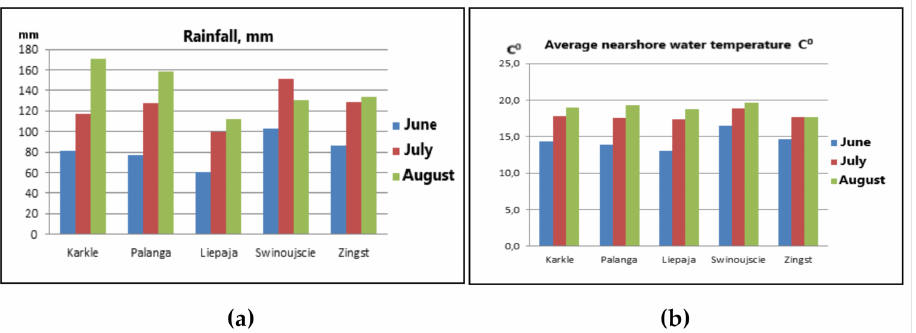
Figure 4. Climate parameters at South Baltic seaside and marine resorts in the summer months from 2010 to 2018 (our compilation): ( a ) Average monthly rainfall (mm); ( b ) Average nearshore water temperature ( ◦ C).